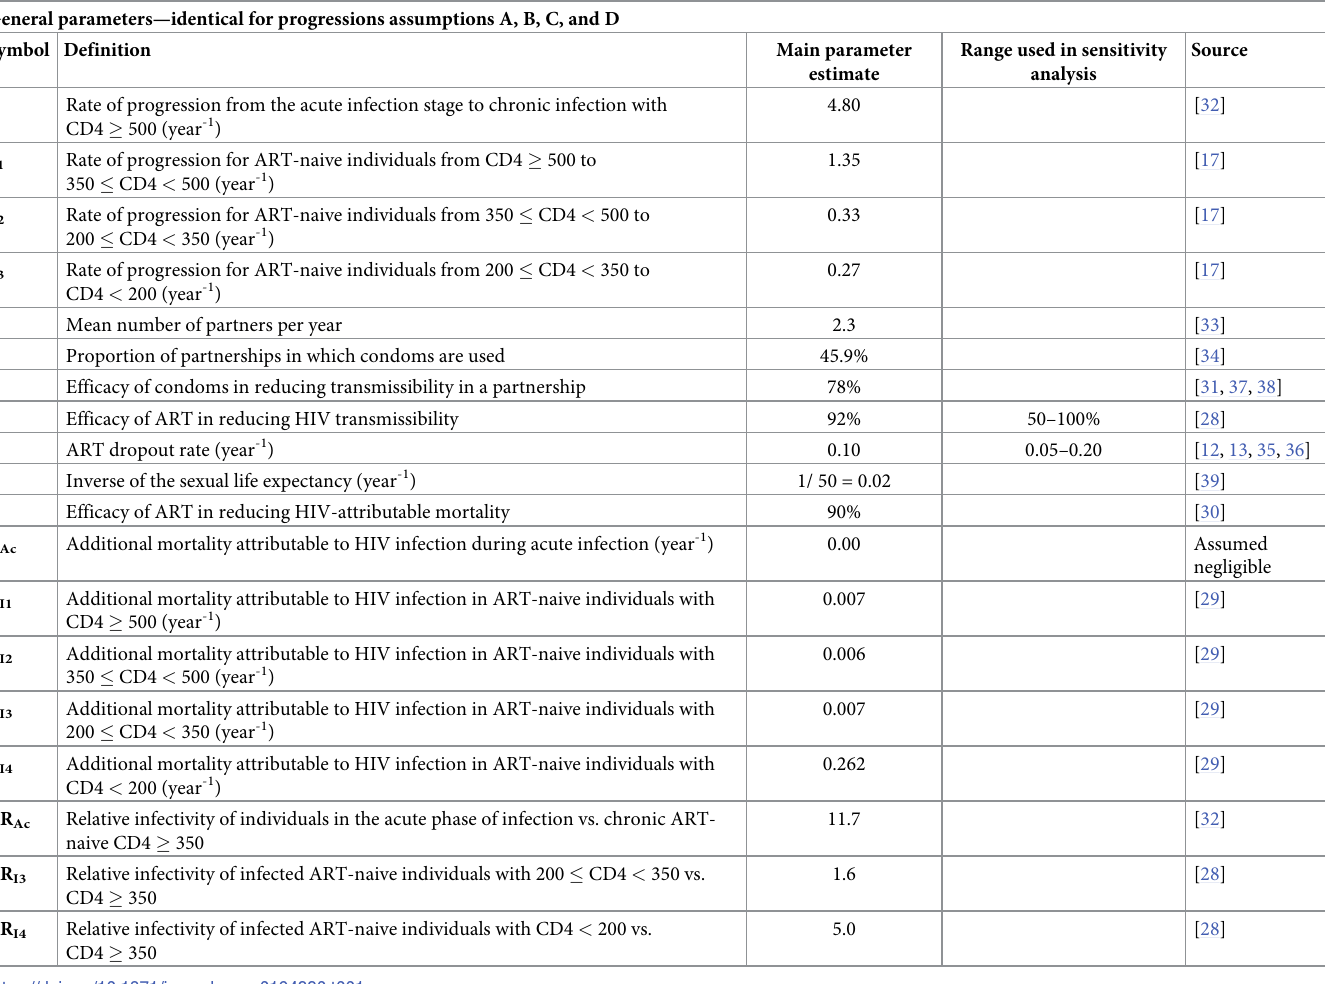
Table 1. General parameter symbols, definitions, baseline values, sensitivity analysis ranges, and sources. General parameters—identical for progressions assumptions A, B, C, and D